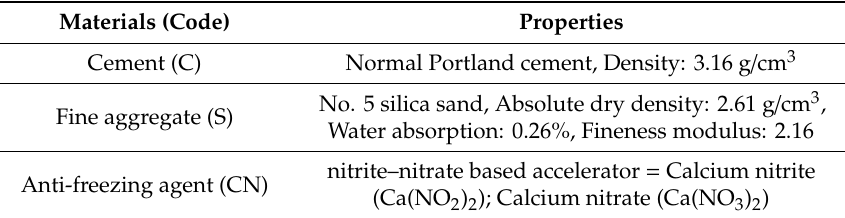
Table 1. Properties of the materials